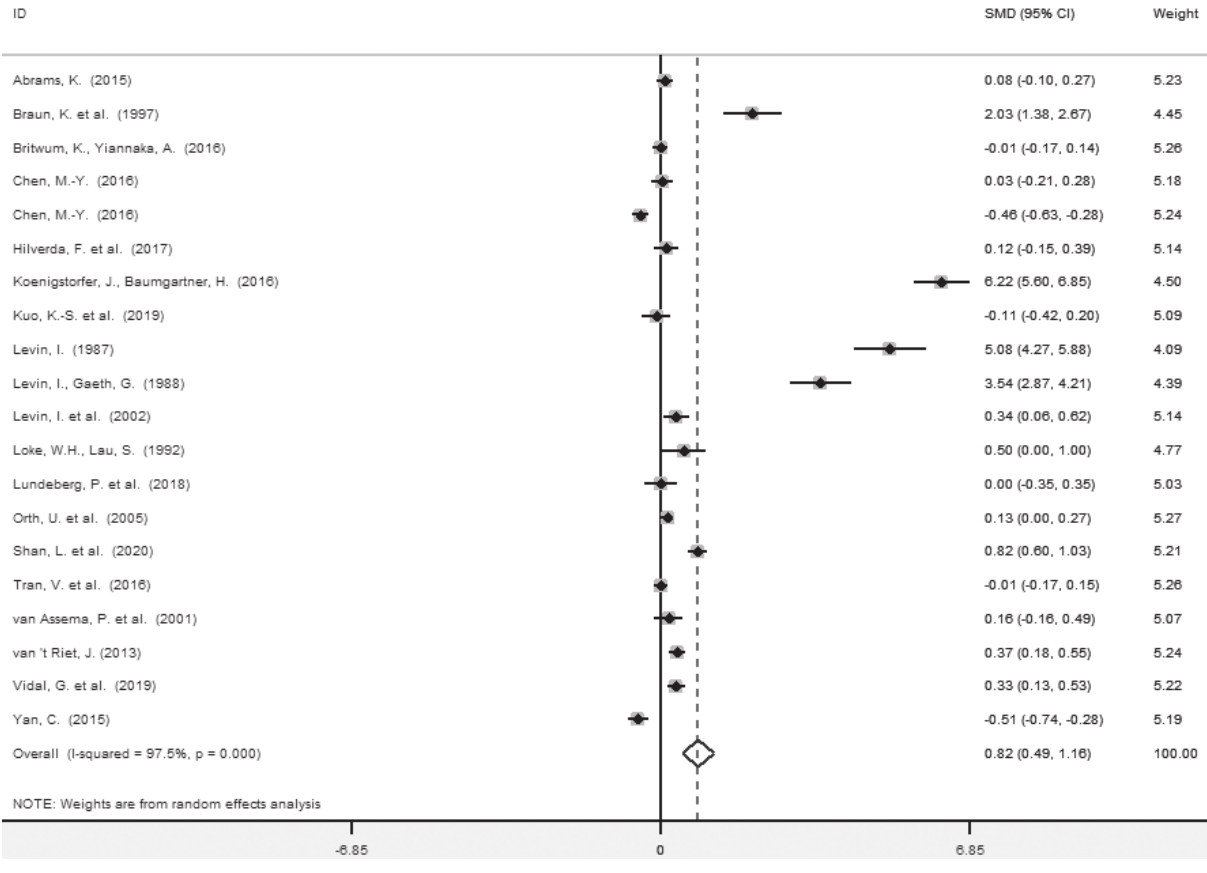
Figure 4. Sub-group meta-analysis results for